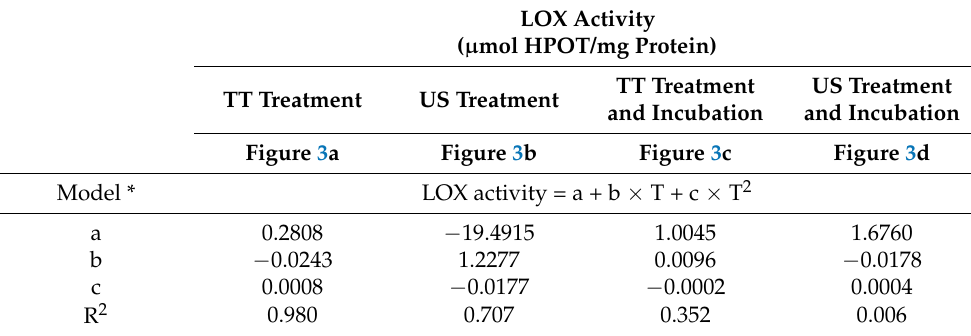
Table 4. Parameter estimates of the exponential curve for lipoxygenase (LOX) activity as a function of temperature.